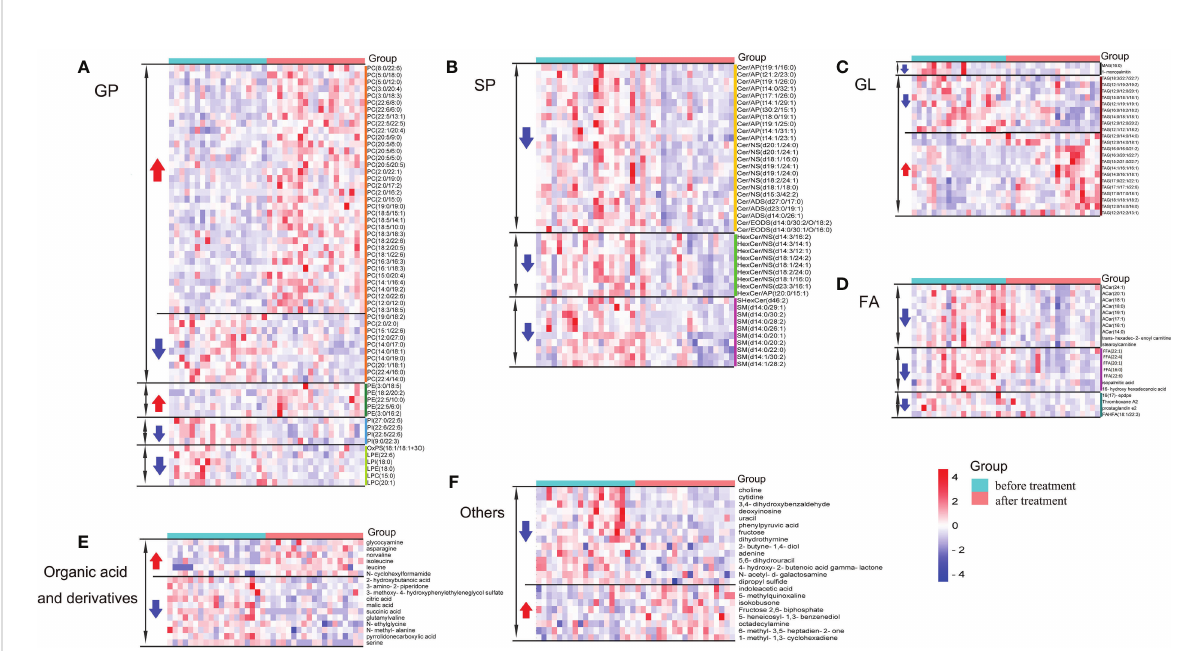
FIGURE 4 Heatmap analysis of unique differentially expressed metabolites speci fi c for well response patients. Heatmap visualization of (A) altered lipids in glycerophospholipids (GP) including PC, PE, PI, Lysophospholipid (LP), and their derivative (B) altered lipids in sphingolipids (SP) including SM, different kinds Cer and its derivative. Besides, beta-glyrrhetinic acid and 4-androsten-11beta-ol-3,17-dione 4 belong to PR and ST, respectively (C) altered lipids in glycerolipids (GL), including TAG and MAG (D) altered lipids in fatty acid (FA) including ACar, FFA and its derivative (E) changes in organic acids and derivatives. (F) changes in some unclassi fi ed metabolites. Acar, Acylcarnitine; Cer/ADS, Ceramide alpha-hydroxy fatty acid-dihydrosphingosine; Cer/ AP, Ceramide alpha-hydroxy fatty acid-phytospingosine; Cer/AS, Ceramide alpha-hydroxy fatty acid-sphingosine; Cer/EODS, Ceramide Esteri fi ed omega-hydroxy fatty acid-dihydrosphingosine; Cer/NDS, Ceramide non-hydroxyfatty acid-dihydrosphingosine; Cer/NS, Ceramide non-hydroxyfatty acid-sphingosine; FFA, Free fatty acid; FAHFA, Fatty acid ester of hydroxyl fatty acid; HexCer/AP, Hexosylceramide alpha-hydroxy fatty acid- phytospingosine; HexCer/NS, Hexosylceramide non-hydroxyfatty acid-sphingosine; LPC, Lysophophatidylcholine; LPE, Lysophosphatidylethanolamine; LPI, Lysophosphatidylinositol; MAG, Monoacylglycerol; MGDG, Monogalactosyldiacylglycerol; OxPS, Oxidized phosphatidylinositol; PC, Phosphatidylcholine; PE, Phosphatidylethanolamine; PI, Phosphatidylinositol; SHexCer, SulfurHexosylceramide hydroxyfatty acid; SM, Sphingomyelin; PR, Prenol Lipids; ST, Sterol Lipids; TAG,